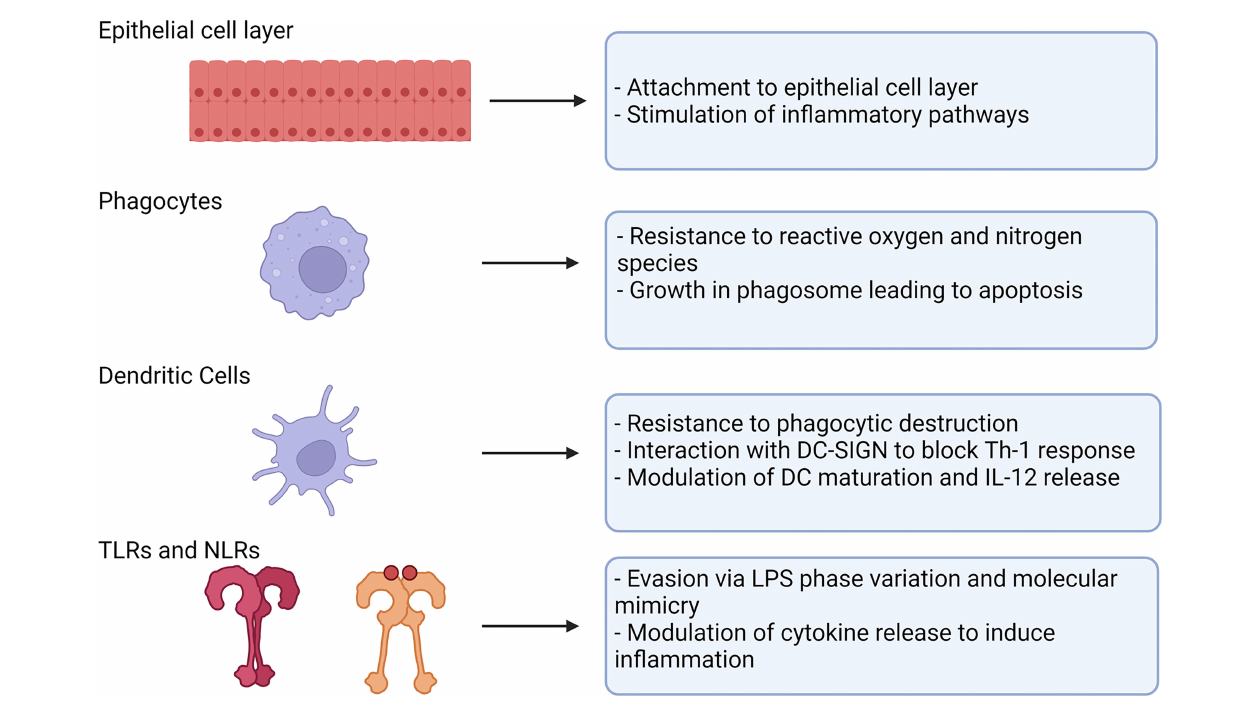
FIGURE 1 | Strategies used by H. pylori to evade innate immune mechanisms. H. pylori uses a number of mechanisms to evade the innate immune system. Various components of the innate immune system present barriers to or respond to H. pylori infection (left). H. pylori is able to overcome these by mechanisms described (right). Created with BioRender.com.